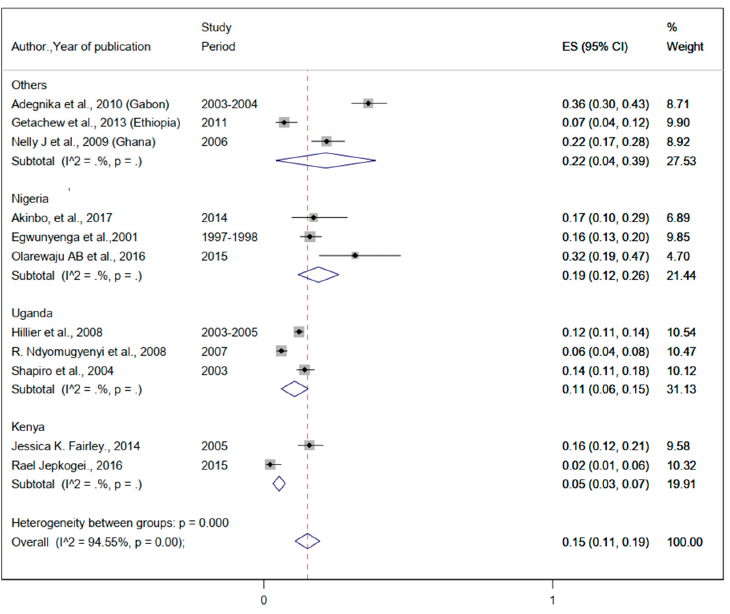
Figure 7. The proportion of Trichuris trichiura estimated from the overall helminthic infection among pregnant women in sub-Saharan Africa. The lowest and the highest prevalence rates of comorbidity with malaria and hel- minths were 3% and 69% (Table 2). The pooled prevalence of malaria and helminthic co- infection was 20% (95%CI: 15%, 26%) (Figure 8).